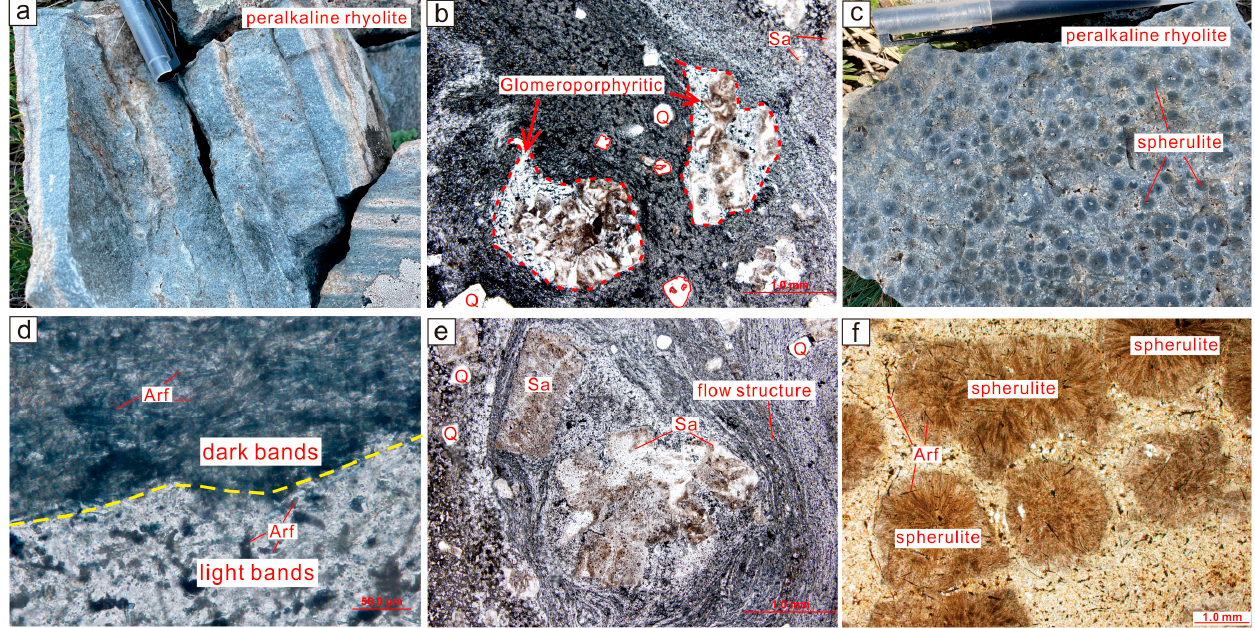
Figure 2. Photographs and photomicrographs of the peralkaline rhyolite dikes in the Baerzhe area. ( a ) Peralkaline rhyolite with flow structure; ( b ) Glomeroporphyritic in peralkaline rhyolite; ( c ) Peralkaline rhyolite with spherulite structure; ( d ) Different bands in the peralkaline rhyolite with flow structure; ( e ) Phenocrysts in the peralkaline rhyolite; ( f ) Photomicrographs of the spherulite in peralkaline rhyolite. Abbreviations: Q = Quartz; Arf = Arfvedsonite; Sa = Sanidine.